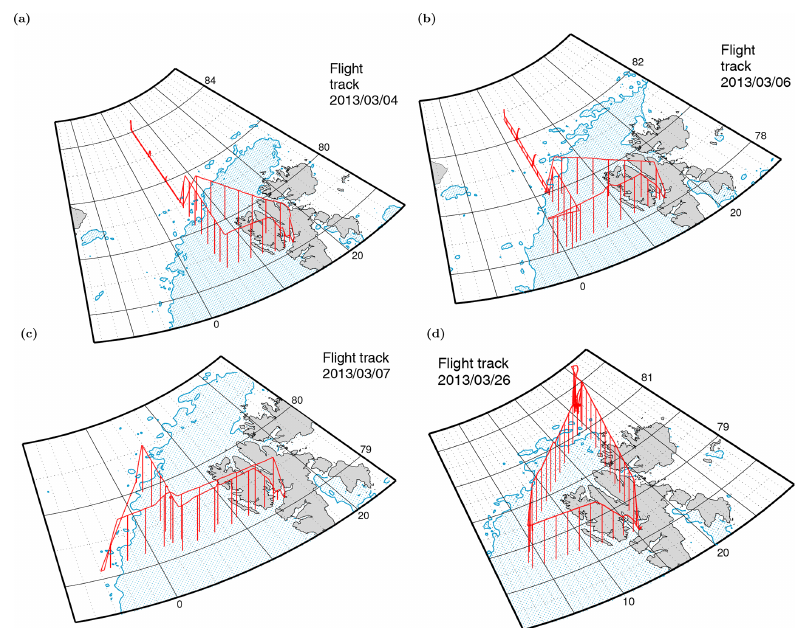
Figure A1. A 3D illustration of the flight tracks on 4 March (a) , 6 March (b) , 7 March (c) , and 26 March 2013 (d) plotted over the ice edge based on a 70% threshold value of the ice concentration (see also Fig. 1 in Sect. 2). The length of the vertical lines between the flight tracks and the surface indicates the height of the aircraft during the research